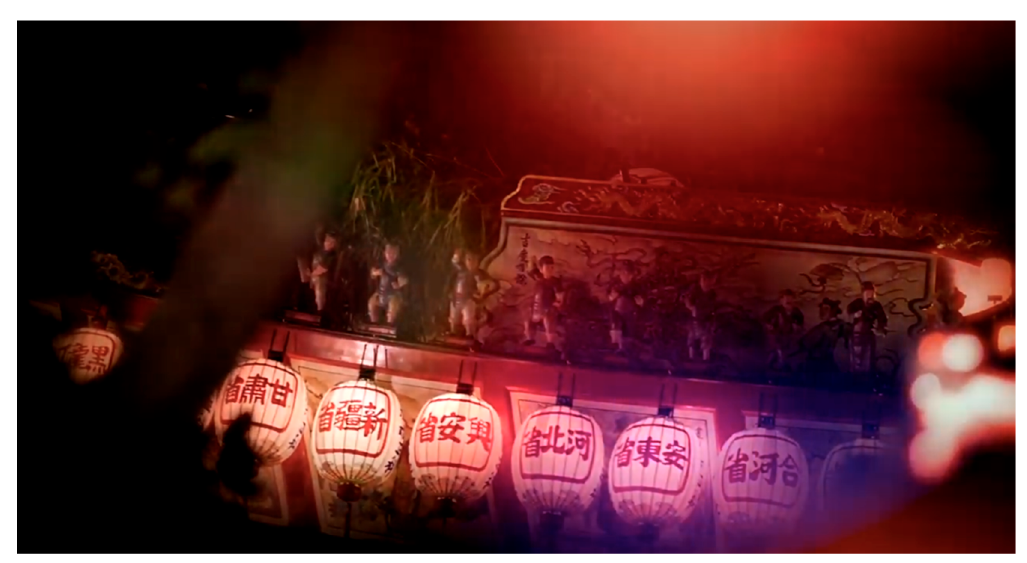
Figure 21. A still-image of film footage from the Wang Yeh boat burning festival in Donggang, Taiwan, by Ye Mimi, which the poet and artist Shin Yu Pai incorporated into her grief ritual. Image courtesy of Ye Mimi and Shin Yu Pai.